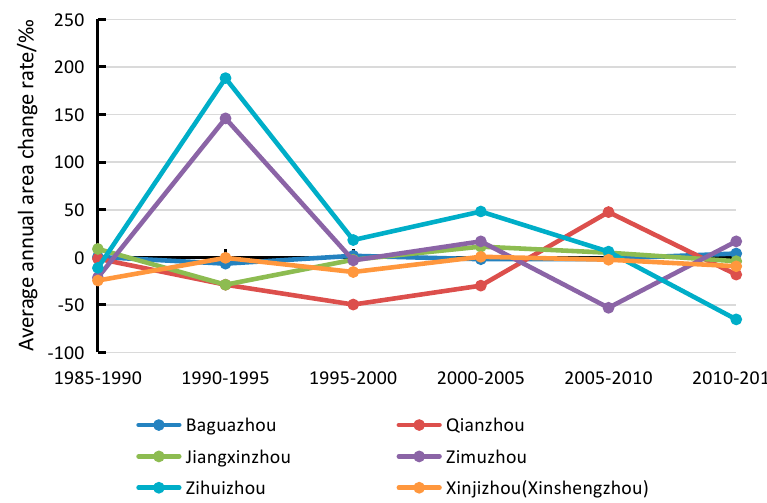
Figure 8. Average annual area change rate of the islands in the study area (‰).